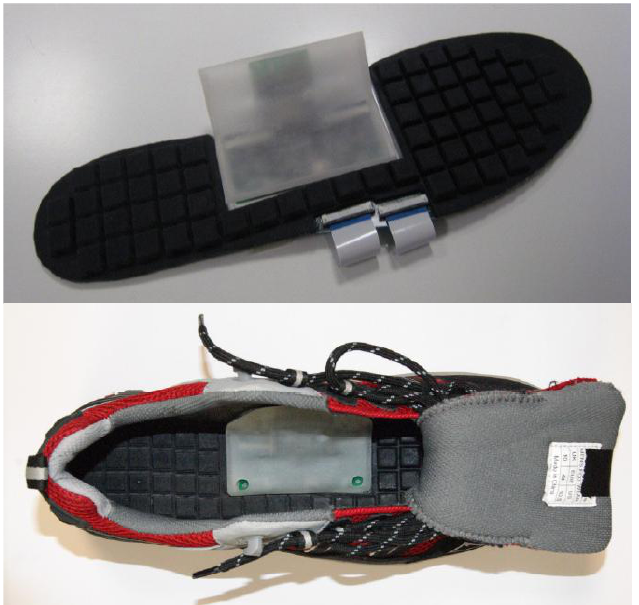
Figure 35. De Rossi et al. insole sensor system and the system fitted inside a